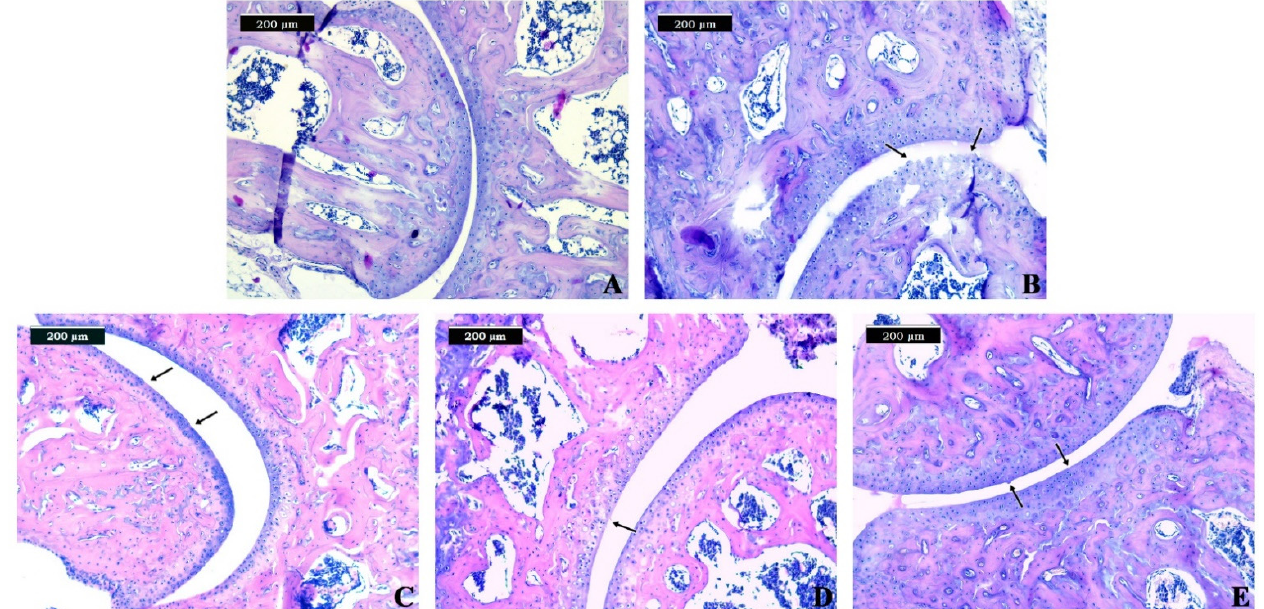
Figure 4. Effects of metformin and alendronate treatments on histopathological changes in the hind paws of collagenase- induced OA in mice. ( A ) Section of normal (control) hind paw showing normal architecture of the cartilage. ( B ) Section of untreated CIOA mice showing vertical fissures and matrix fibrillation extending into the mid zone. ( C ) Section of CIOA mice treated with metformin showing an uneven articular surface and small fibrillations. ( D ) Section of CIOA mice treated with alendronate showing focally fibrillation extending through the superficial zone. ( E ) Section of CIOA mice treated with metformin+alendronate showing an uneven articular surface and superficial fibrillation.